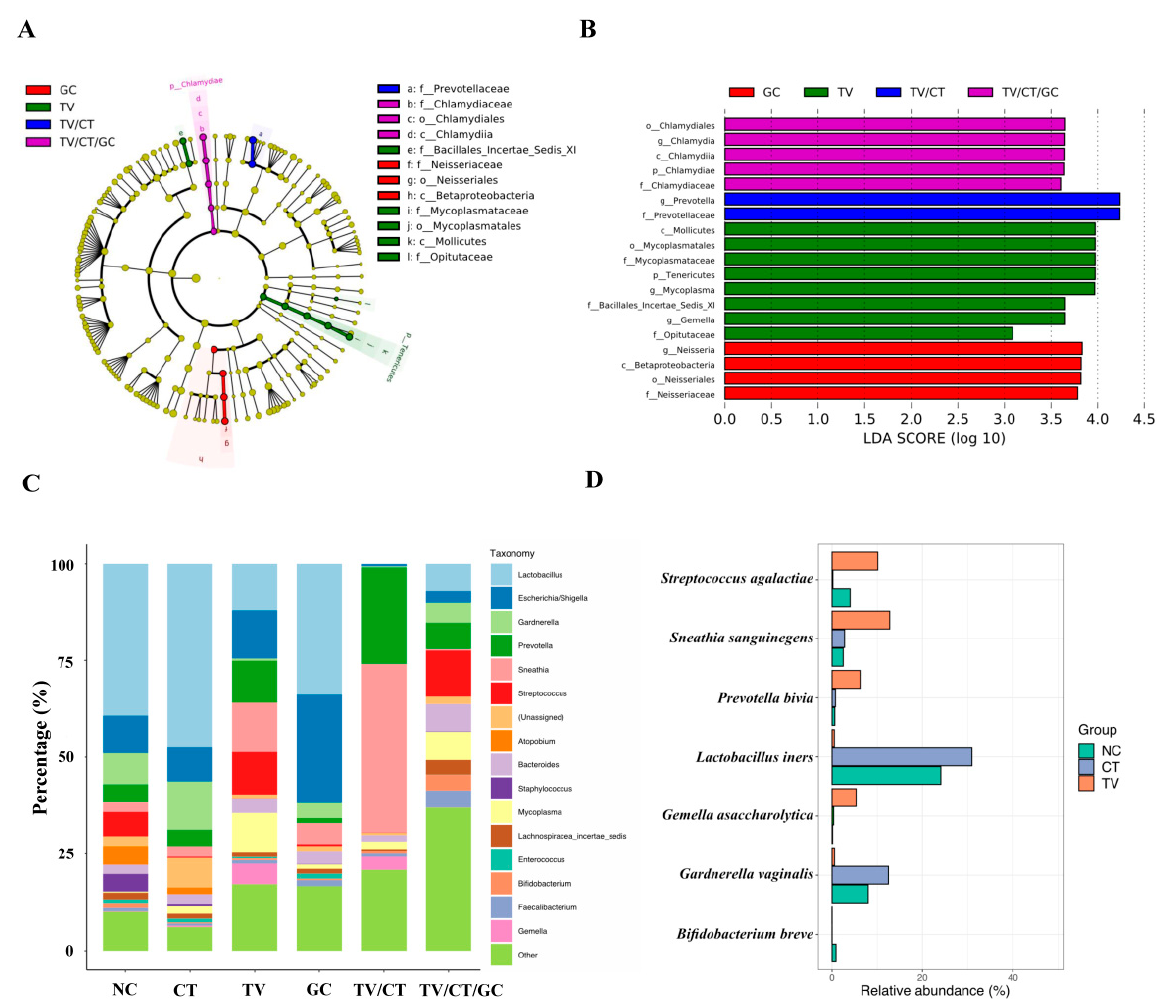
Figure 3. The differentially enriched bacteria in STI-positive patients compared to the non-STI (NC) group. ( A ) Cladogram generated by linear discriminant analysis effect size (LEfSe) indicated differences in taxa among STI-positive and the NC groups ( B ) Histogram of the linear discriminant analysis (LDA) scores for differentially abundant taxonomic features among the STI-positive and NC groups. ( C ) Taxonomic profiles of the most abundant bacterial genus among the STI-positive patients and NC groups. ( D ) The enriched bacterial species was highlighted in CT- and TV-positive patients compared with the NC group.